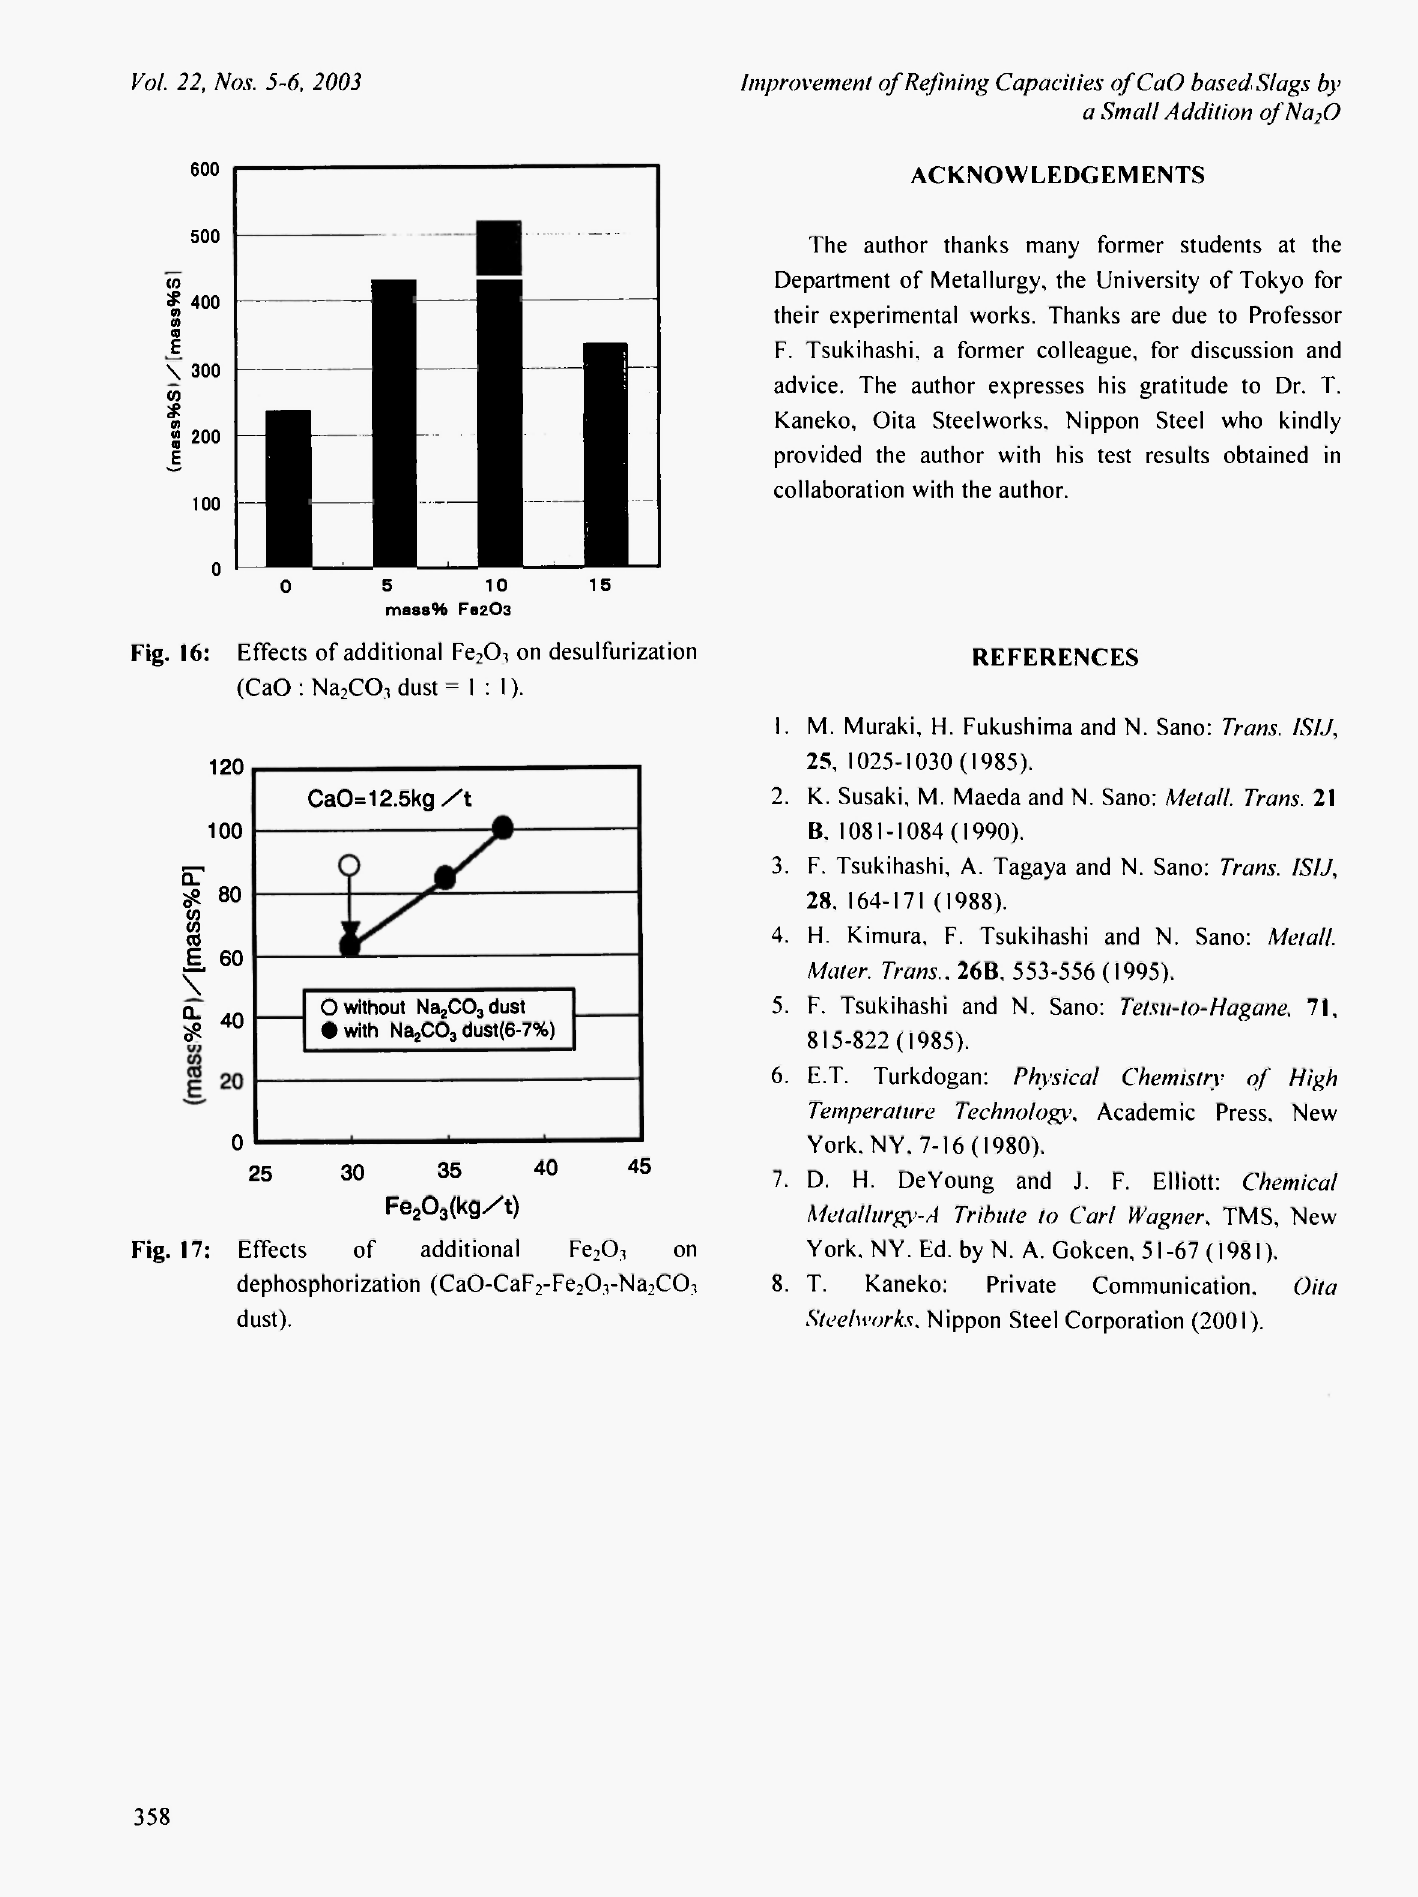
Fig. 17: Effects of additional F e^ on dephosphorization (Ca0-CaF 2 -Fe 2 0 :! -Na 2 C0: !